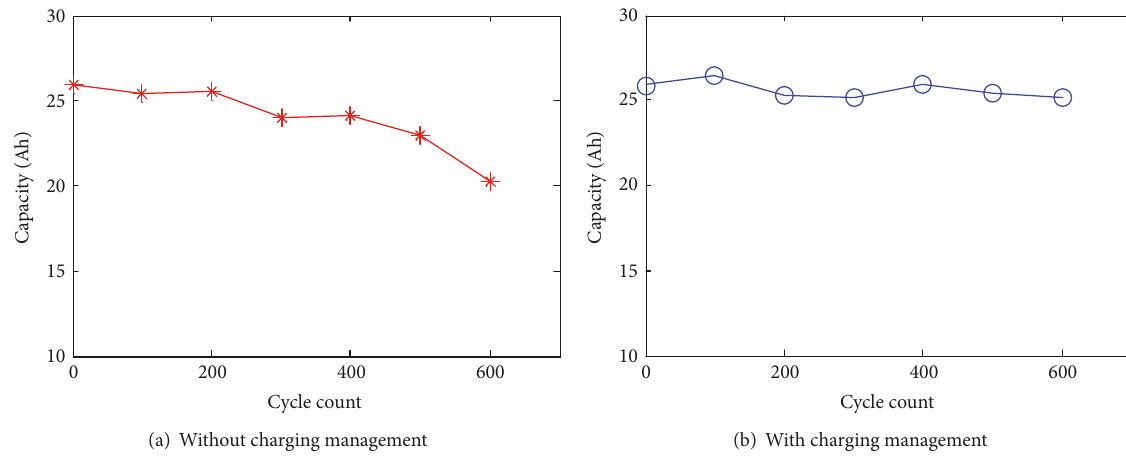
Figure 14: Effect of the charging